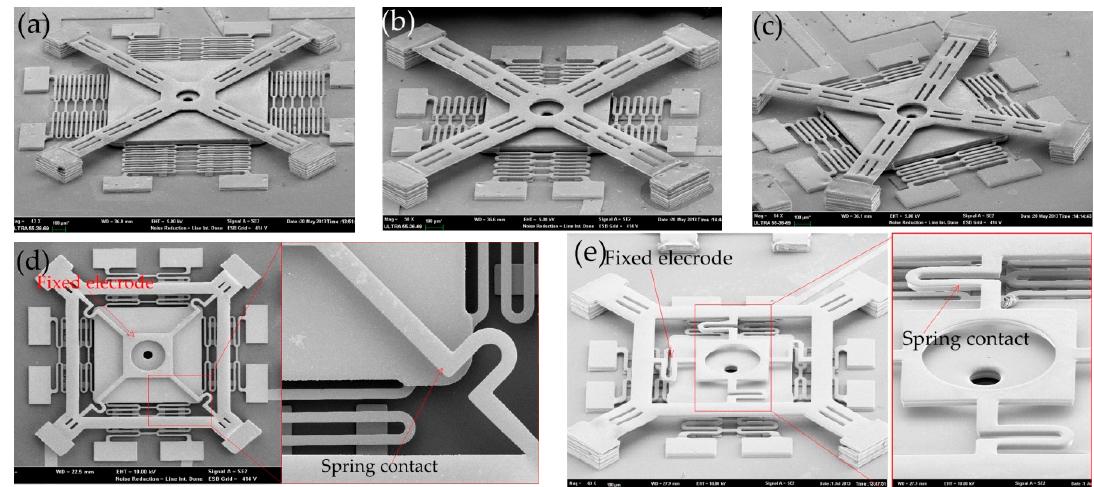
Figure 11. SEM images of prototype devices. ( a – c ) Inertial switch using simply supported beams as the fixed electrode, ( d , e ) inertial switch using a spring as the fixed electrode.